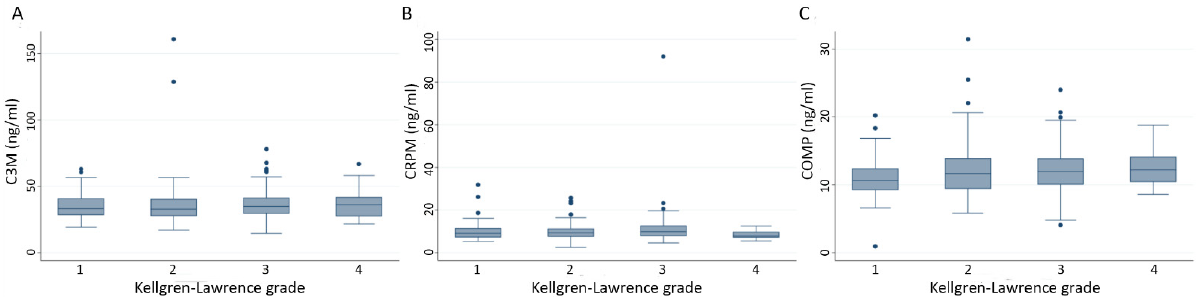
Figure A2. Biochemical marker level by Kellgren–Lawrence grade. ( A ) Type III collagen degradation (C3M); ( B ) metabolite of C-reactive protein (CRPM); ( C ) cartilage oligomeric matrix protein (COMP).